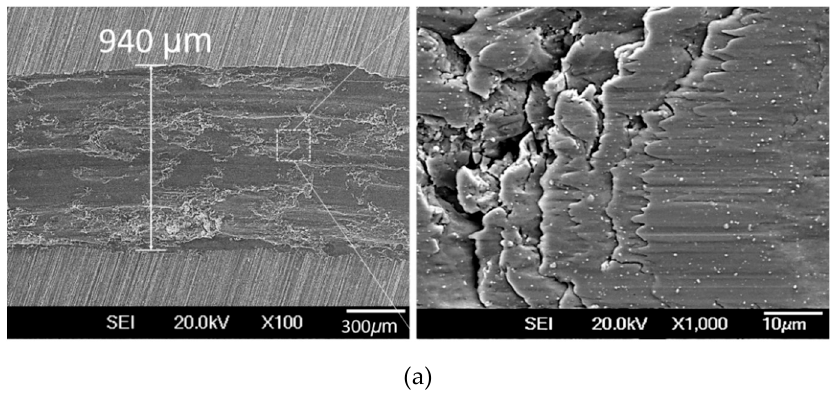
Figure 8. ( a ) Images of wear scars after the ball-on-disc wear test, and ( b ) comparison of weight loss and wear scars.